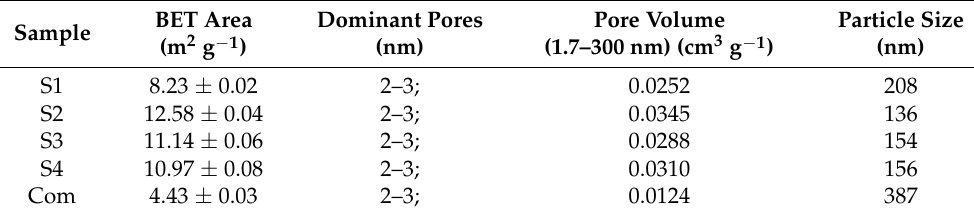
Table 2. BET parameters for the sol–gel synthesized LTO samples and commercial sample.